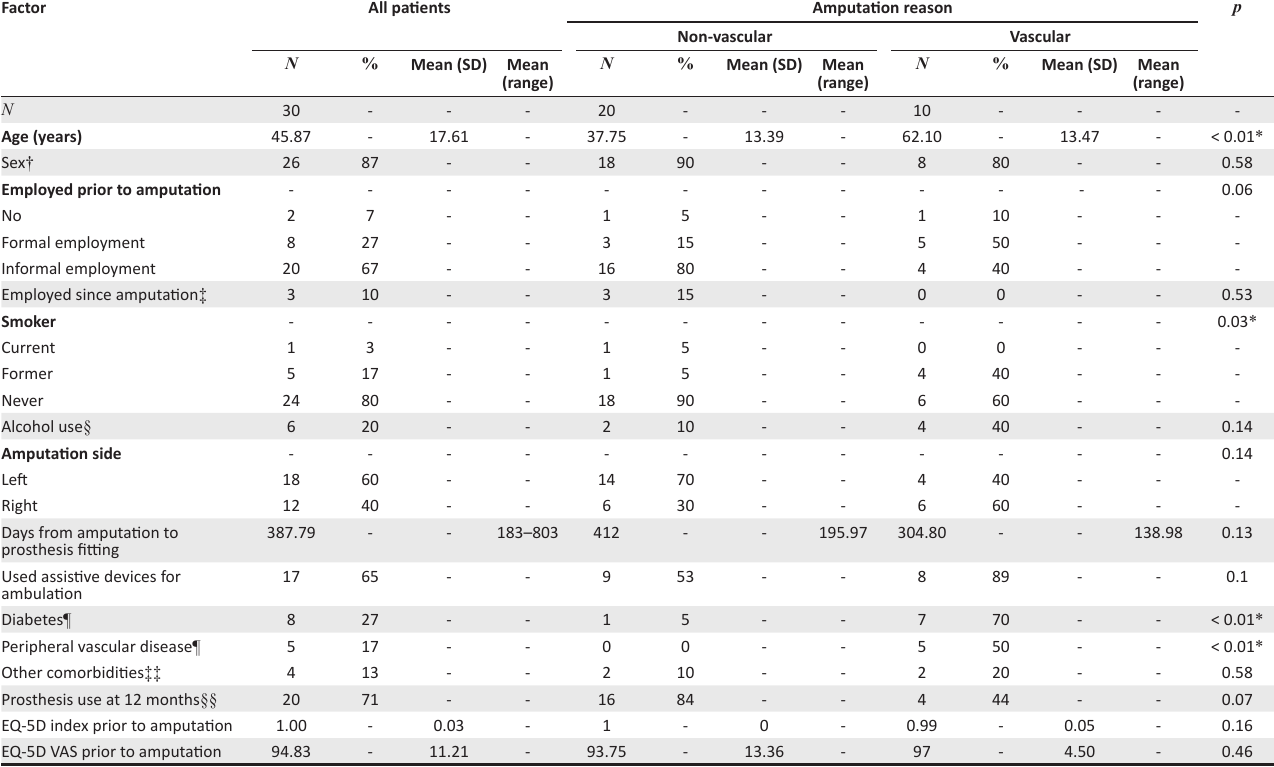
FIGURE 2 : Flowchart demonstrating screening, enrolment and follow-up for study participants. TABLE 1: Patient